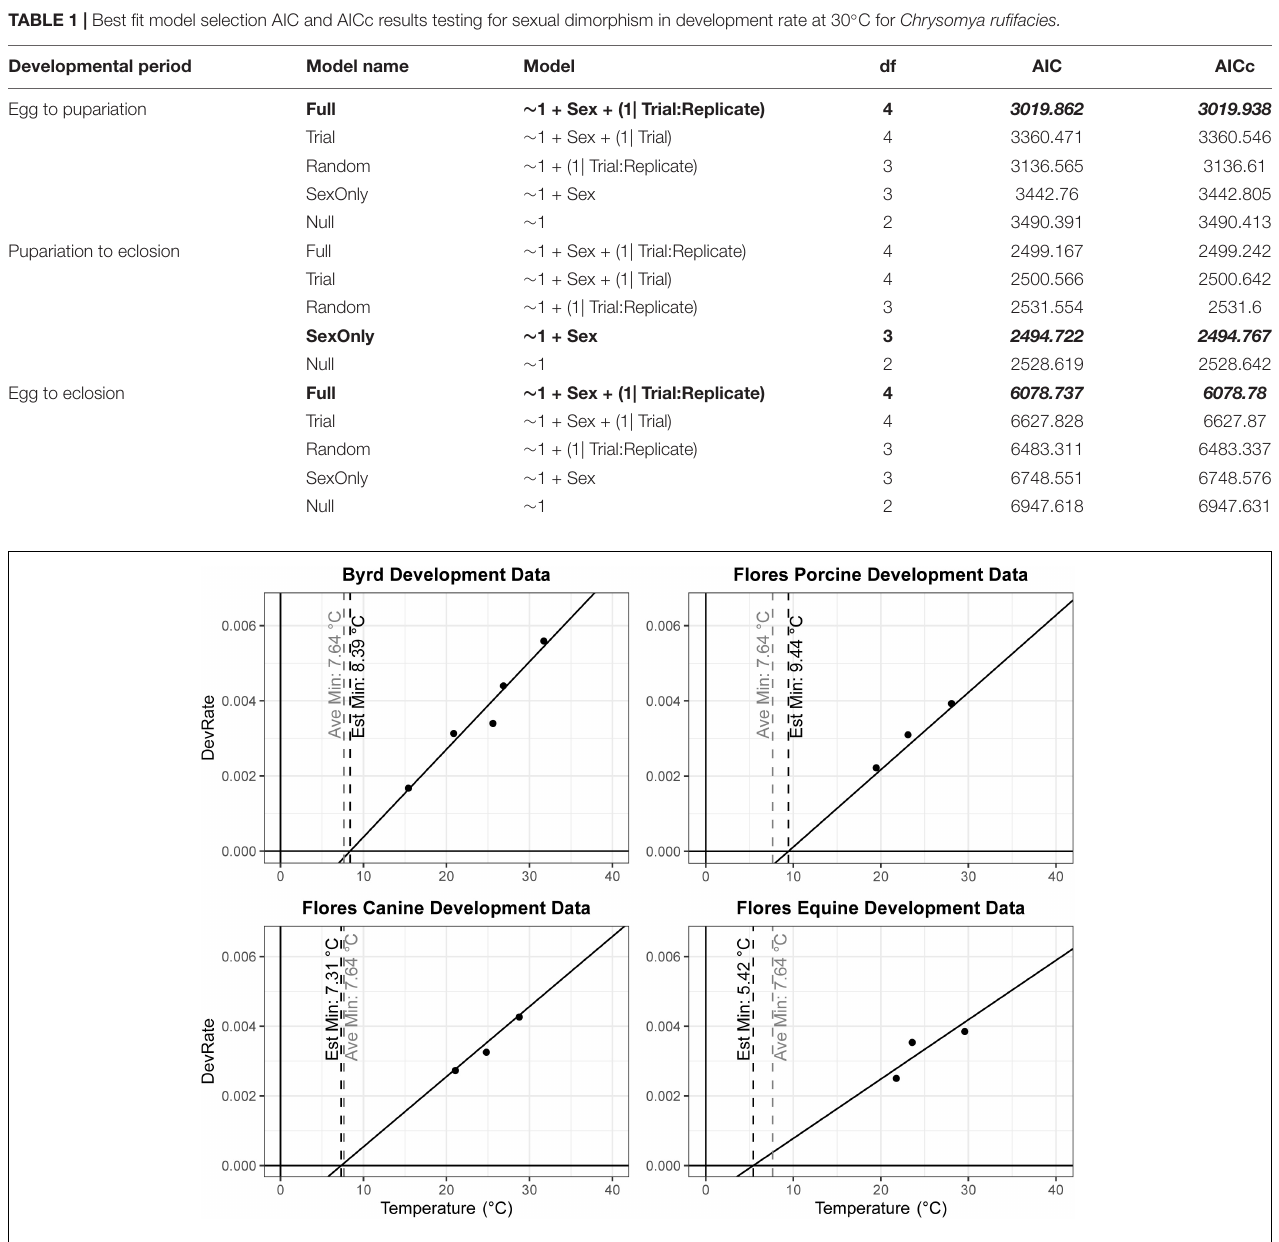
FIGURE 1 | Linear regression models to estimate lower developmental threshold of North American collected Chrysomya rufifacies. The estimated LDT for each data set was identified individually by calculating the x-intercept (vertical black dashed line). These estimates were averaged together and also plotted (vertical gray dashed line at 7.64 ◦ C in all